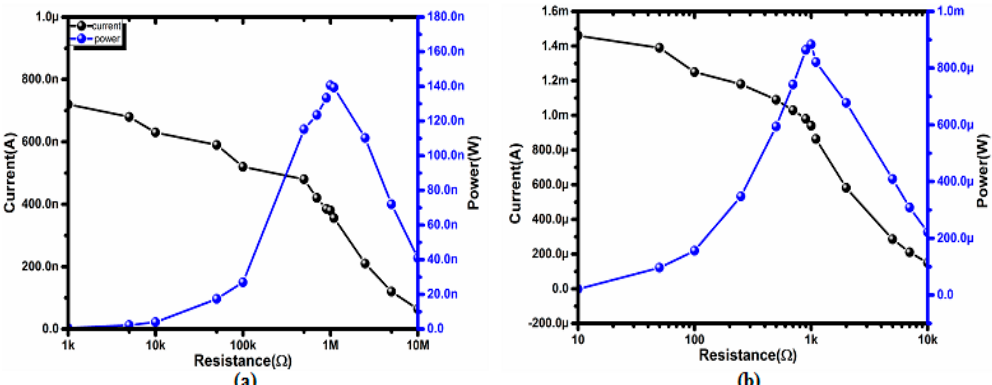
Figure 12. Relationship between the output power/current and the loading resistance: ( a ) TENG; and ( b ) EMG.